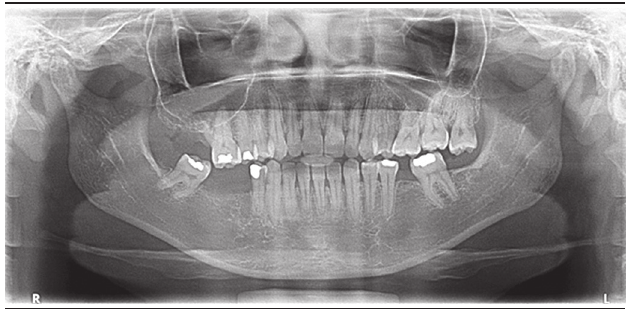
FIgure 2 – Panoramic radiograph with absence of radiographic changes in the region of the lesion